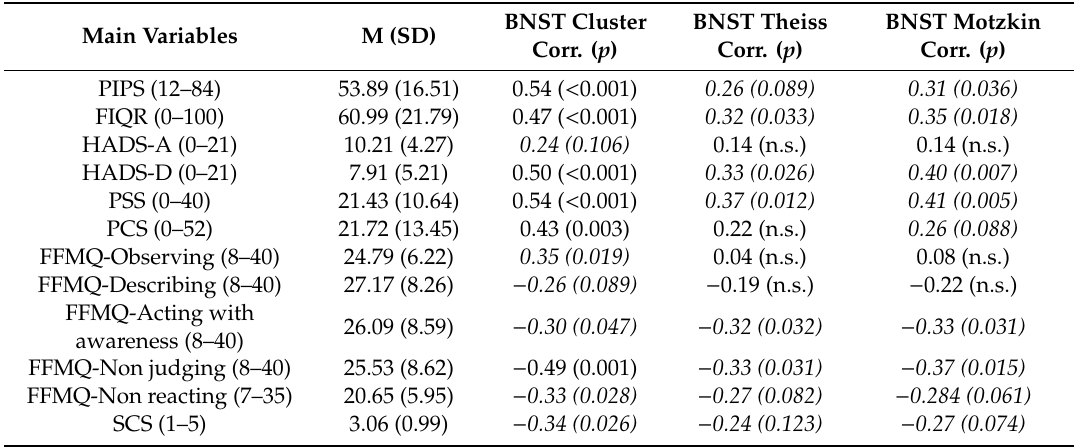
Table 2. Means, standard deviations and correlations among main variables (i.e., PIPS and gray matter volumes in the BNST cluster, clinical and third-wave cognitive measures.